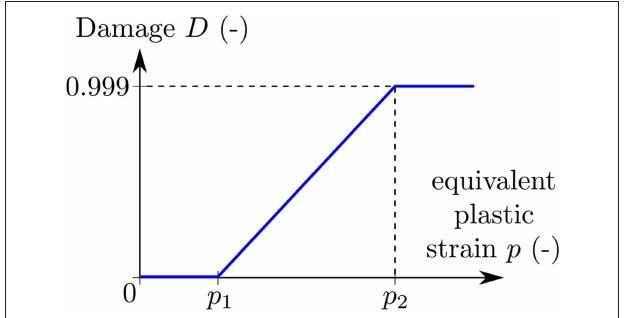
FIGURE 2 | Local damage model for the numerical computation with p 1 and p 2 being the lower and upper limit defining the start and saturation of